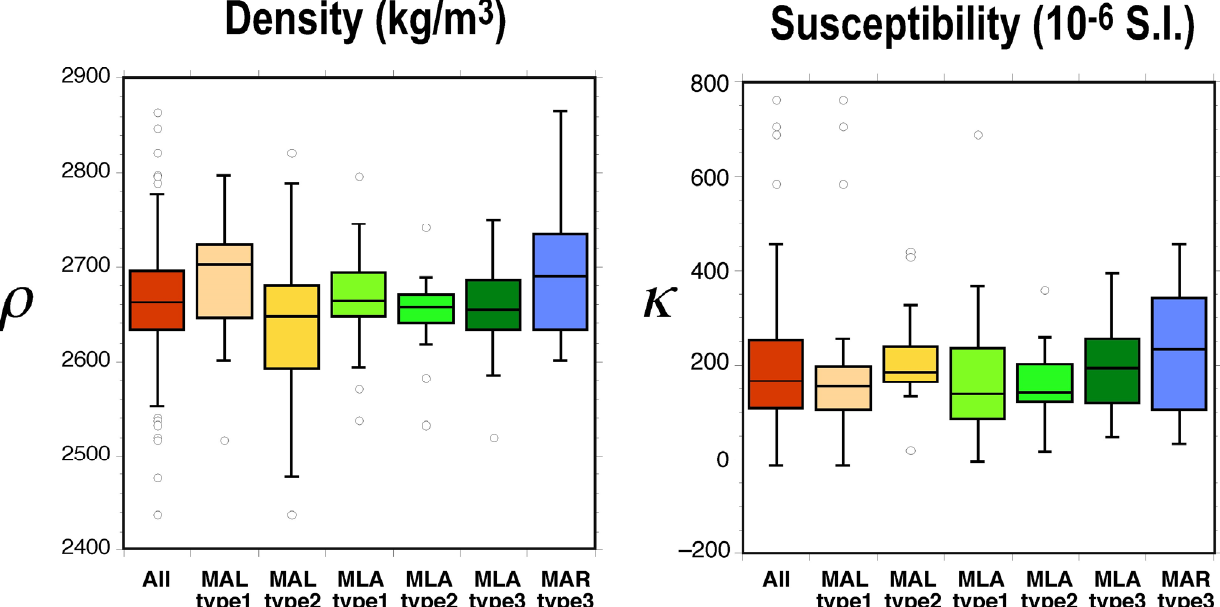
Figure 8. Natural variability of density and magnetic susceptibility as a function of sample type and granitic body (only data from this study are shown, see data overview in Table 3). The three plutons are plotted with different colors Maladeta (orange), Marimanha (blue), Mont-Louis- Andorra (green). The red box-plots comprise all data together.